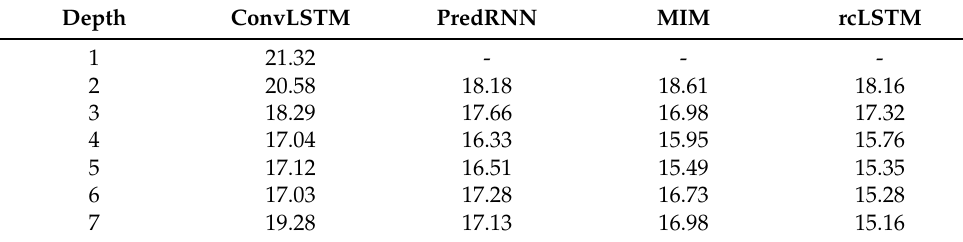
Table 3. MSE scores for the 10-frames-lead forecast for the models with different depths.